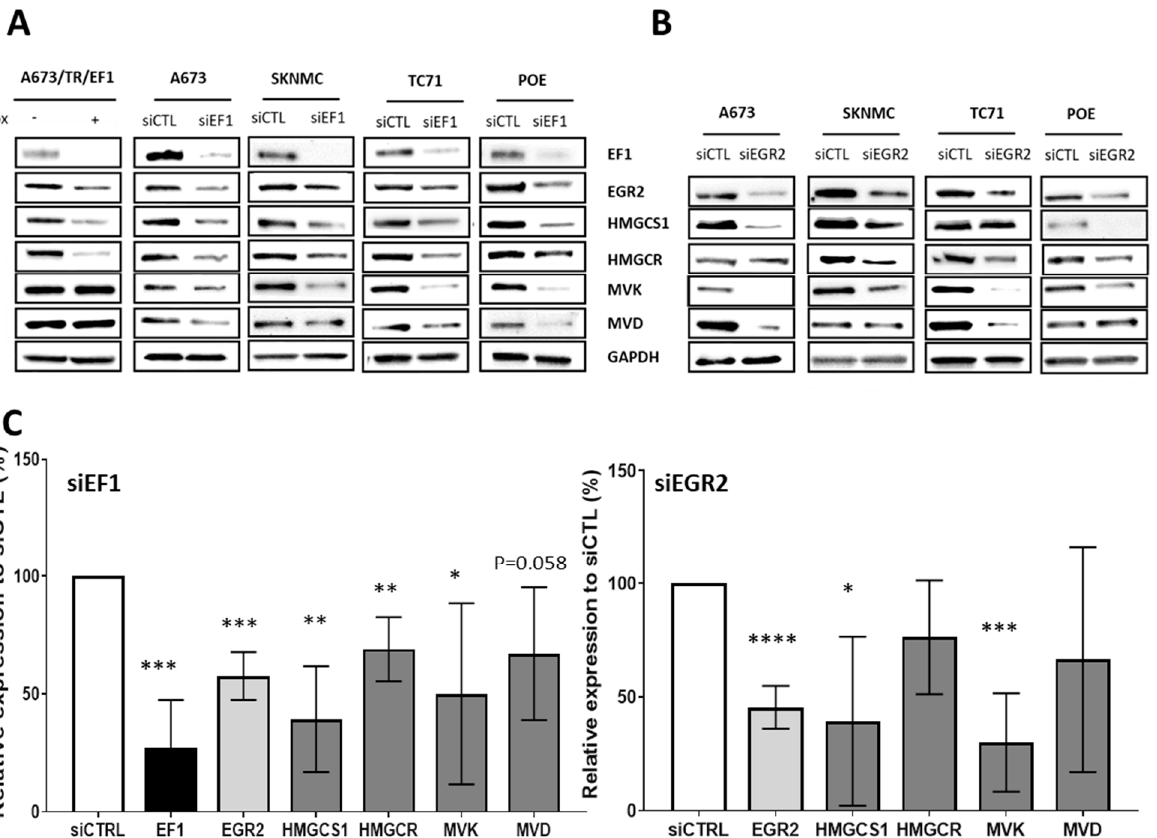
Figure 2. EWSR1-FLI1 and EGR2 regulate the protein expression of the mevalonate pathway in Ewing cells. ( A , B ) Western blot analysis of HMGCS1, HMGCR, MVK, and MVD expression in total lysates of the A673, SKNMC, TC71, and POE Ewing cell lines transfected with a control siRNA (siCTRL) or with siRNA targeting EWSR1-FLI1 (siEF1) ( A ) or EGR2 (siEGR2#1) ( B ) for 72 h. The A673/TR/shEF1 inducible cellular model was treated with doxycycline for 7 days (+Dox) to invalidate the EWSR1-FLI1 expression or was untreated ( − Dox). ( C ) Quantification of protein expression levels of EWSR1-FlI1, EGR2, HMGS1, HMGCR, MVK, and MVD after invalidation by siRNA of EWSR1-FLI1 (siEF1) or EGR2 (siEGR2#1) for 72 h; the graph represents the relative expression to siCTRL for each cell line. The histograms correspond to the mean value of all Ewing cell lines (n = 4). Data are presented as mean +/ − SD. **** p value < 0.0001, *** p value < 0.001, ** p value < 0.01, * p value < 0.05 versus